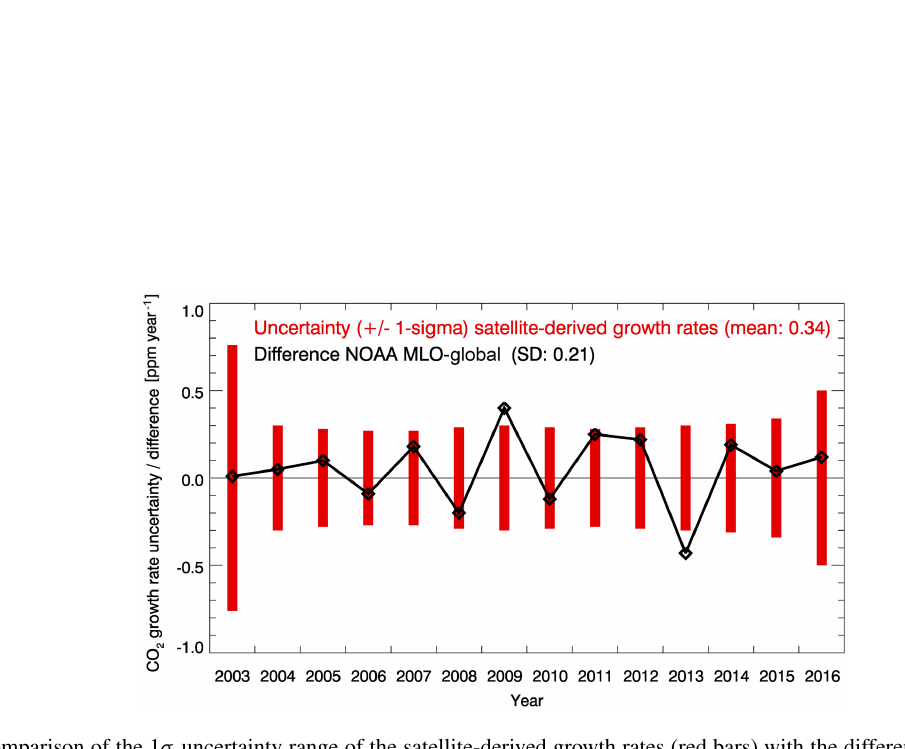
Figure A1. Satellite-derived annual mean XCO 2 growth rates: global (black), Northern Hemisphere (NH) midlatitudes (NHmidlat, 30–60 ◦ N, red), tropics (30 ◦ S–30 ◦ N, green), and Southern Hemisphere midlatitudes (SHmidlat, 60–30 ◦ S, blue). The corresponding numerical values are listed in Table A1.